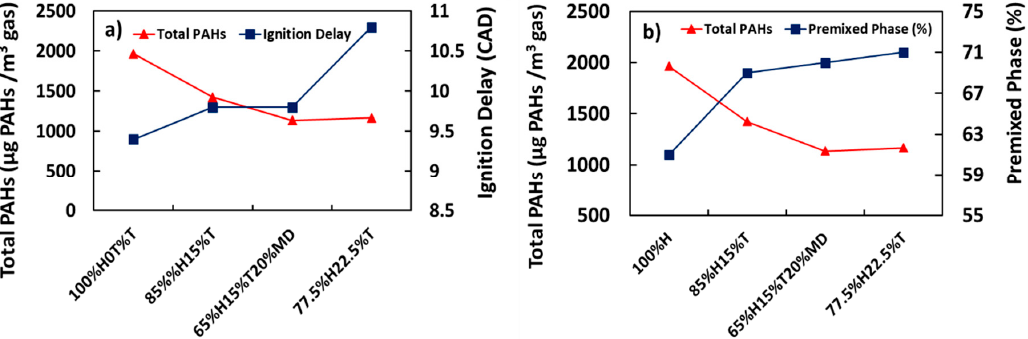
Figure 5. Correlation of total PAH ( µ g PAH / m 3 gas) with ( a ) ignition delay (Crank Angle Degrees, CAD) and ( b ) premixed phase (%).